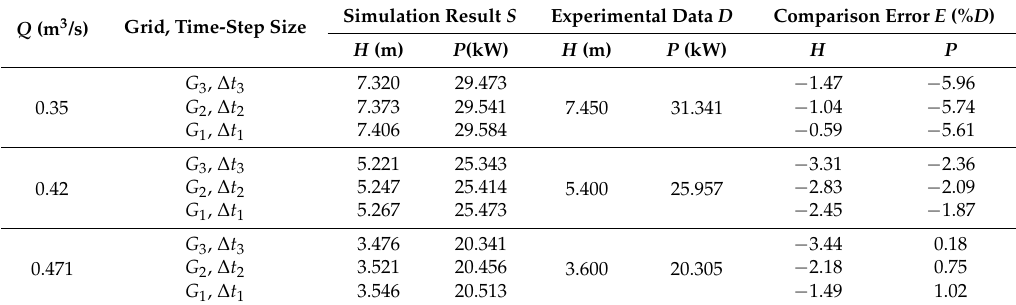
Table 3. Comparison of simulation results and experimental data [25] for the axial-flow pump.